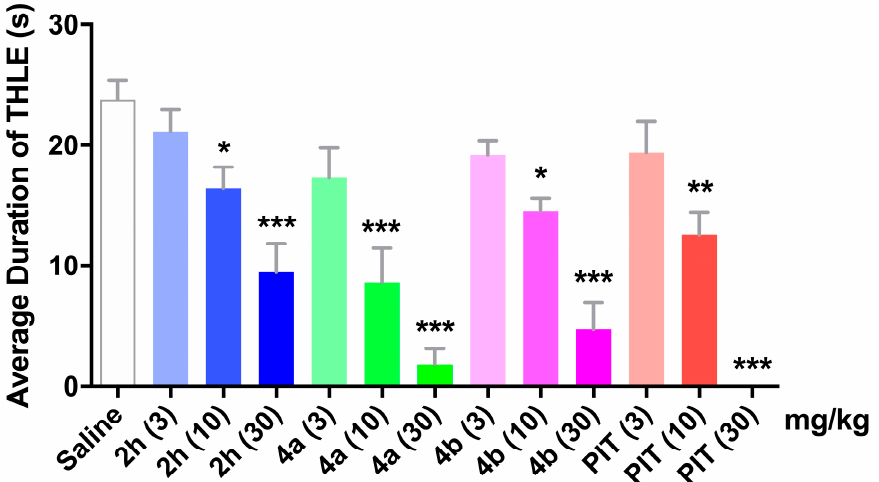
Figure 4. The protection of compounds 2h , 4a , 4b , and PIT against the maximal electroshock-induced seizures in doses of 3, 10, and 30 mg/kg. * p < 0.05, ** p < 0.01, *** p < 0.001 when compared to the control group (saline).